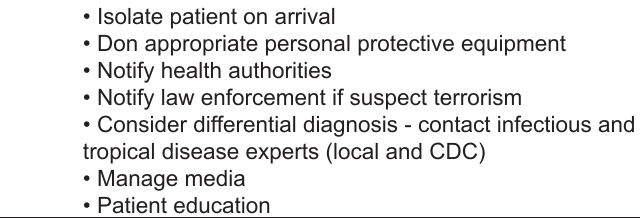
Figure 2. Critical actions for emergency physicians caring for febrile travelers who might have Ebola or other infections transmitted from